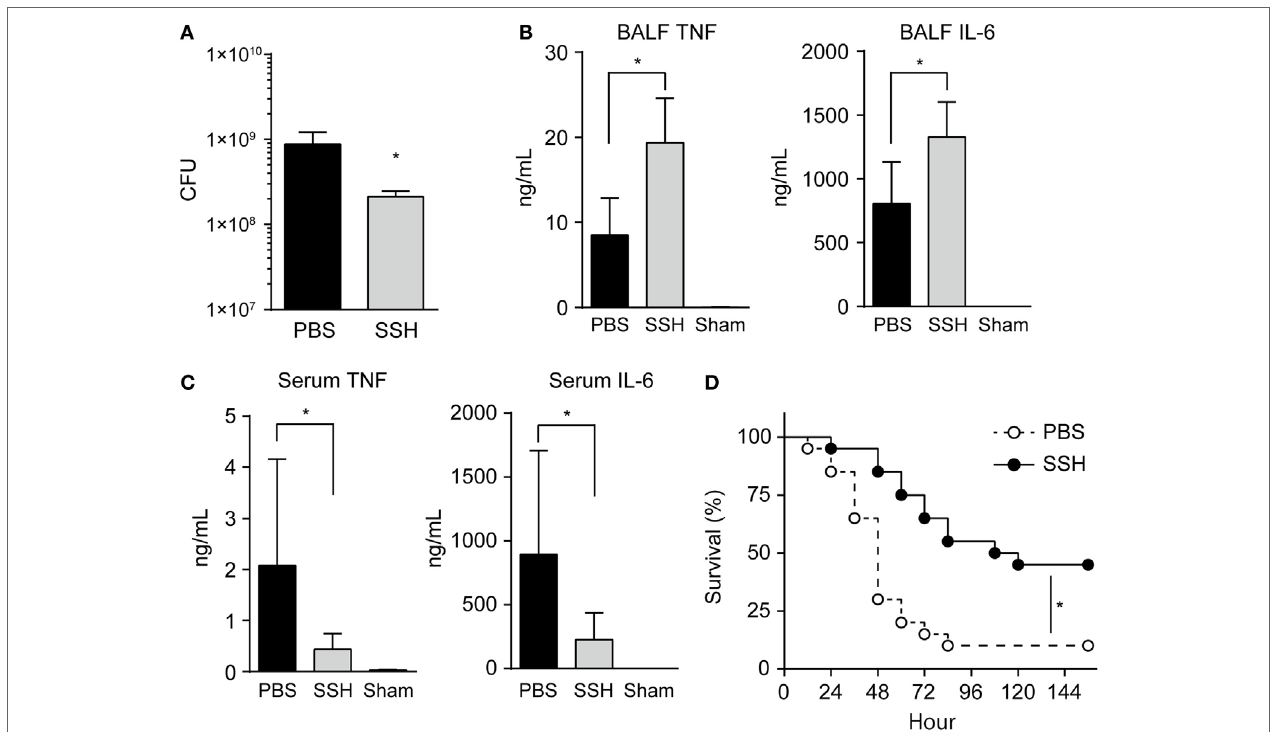
FigUre 6 | Administration of NE inhibitor increases cytokine level and decreases bacterial load in BALF. BALB/c mice (seven mice each) were intratracheally infected with Streptococcus pneumoniae D39 (2 × 10 8 CFU in 50 µL PBS). Unchallenged naive mice (Sham group) were administered PBS only. NE inhibitor (SSH group; 50 mg/kg) or PBS (PBS group) was administrated intraperitoneally to the infected mice every 6 h. (a–c) Groups of animals were sacrificed at 18 h postinfection. (a) BALF samples were plated onto blood-agar plates and cultured aerobically for enumerating recovered CFU. Data represent the mean ± SD and were evaluated using unpaired t tests. *Significantly different from the infected control group at P < 0.05. (B) The levels of TNF and IL-6 in BALF were determined by using ELISA kits. (c) Serum TNF and IL-6 levels were determined. (B,c) Data represent the mean ± SD and were evaluated using one-way analysis of variance with Tukey’s multiple-comparisons test. *Significantly different from the infected control group at P < 0.05. (D) Survival of BALB/c (twenty mice each) mice was monitored following the intratracheal infection with S. pneumoniae (5 × 10 8 CFU) in the presence or absence of intraperitoneal administration of an NE inhibitor. Statistical analysis was performed with log-rank test. *Significantly different from the SSH-untreated control at P < 0.001. BALF, bronchoalveolar lavage fluid; CFUs, colony forming units; ELISA, enzyme-linked immunosorbent assay; NE, neutrophil elastase; PBS, phosphate buffered saline; SSH, sivelestat sodium hydrate; IL, interleukin; TNF, tumor necrosis